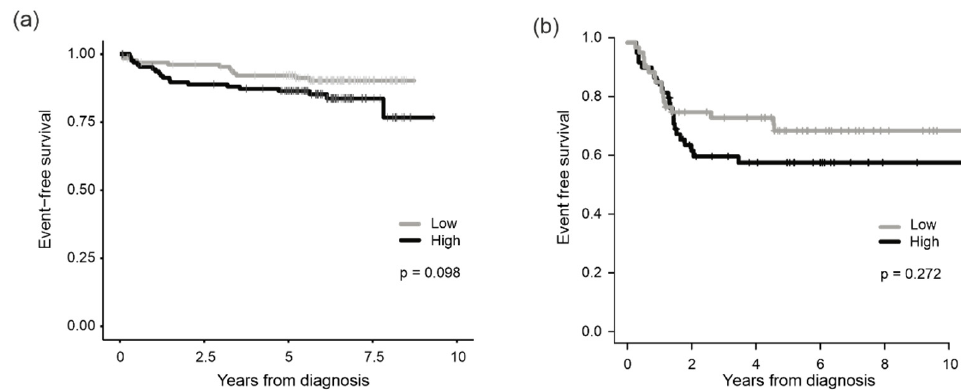
Figure 2. Association of PRMT7 expression with patient outcome. EFS of patients in ( a ) the TARGET and ( b ) the Japanese patient cohorts. Patients were classified into two groups by using the median expression value of PRMT7 as a cut-off.